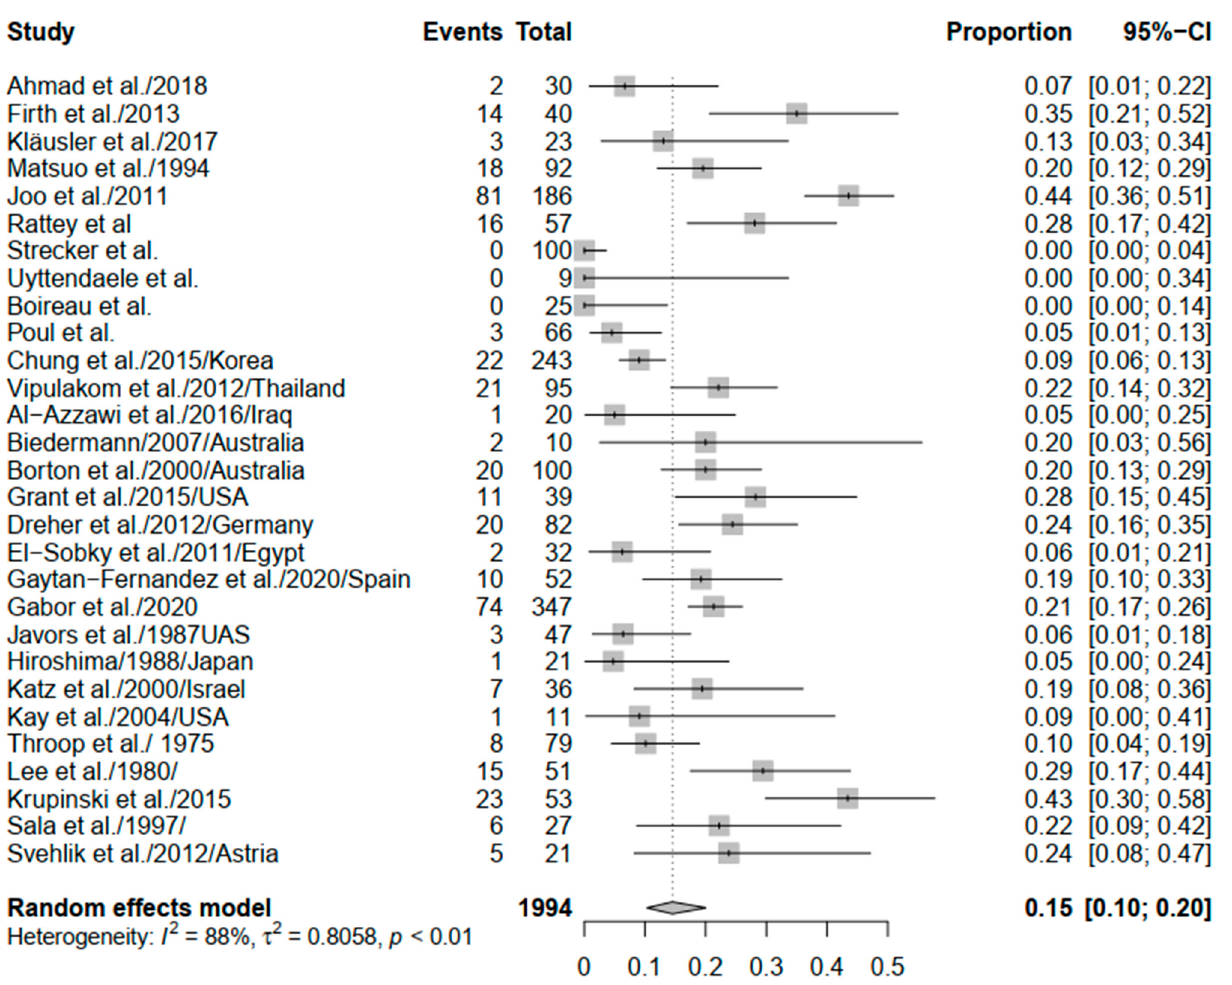
Figure 2. Forest plot of the overall recurrence of equinus.